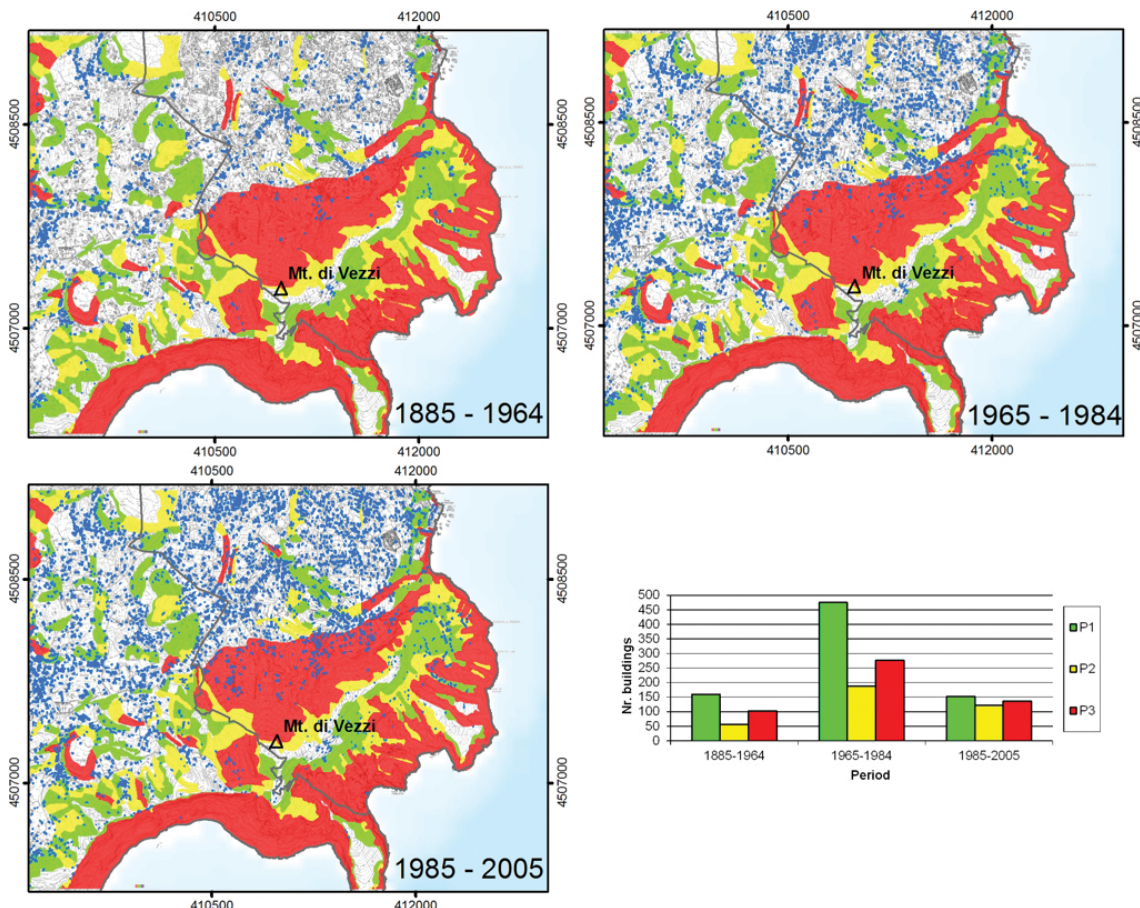
Fig. 21. 1885–2005 temporal distribution of the dwellings built in the southeastern part of the Ischia island. Key to symbols: P1 = low relative hazard; P2 = medium relative hazard; P3 = high relative